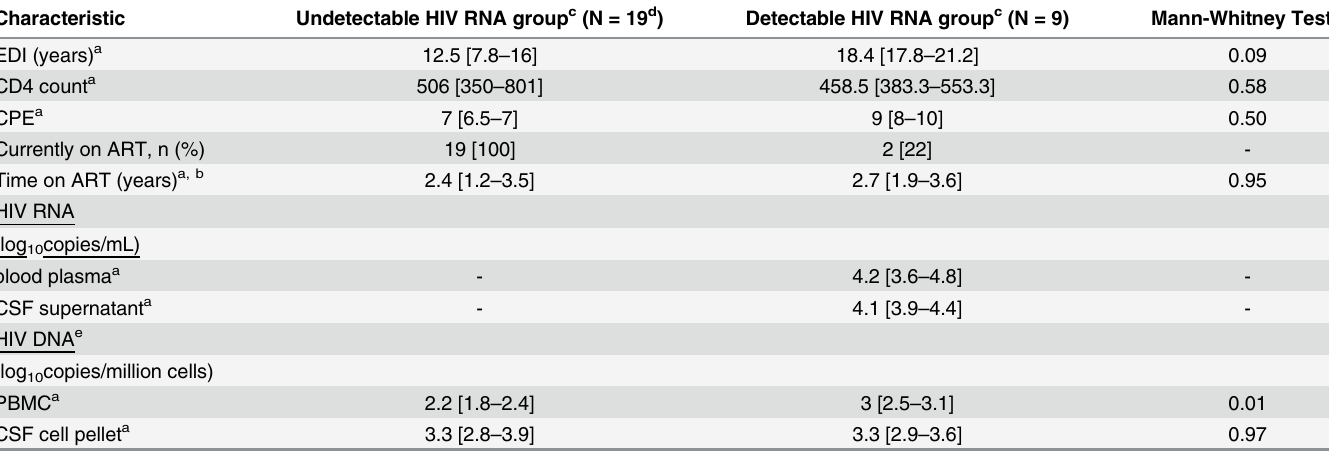
Table 1. Population characteristics and levels of HIV RNA and DNA in PBMC and